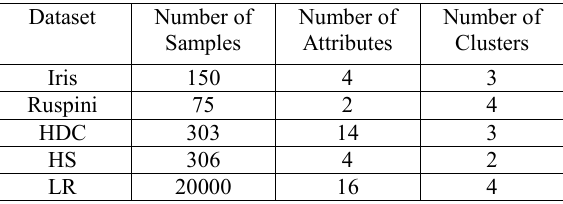
Table 1. Features of Real Datasets